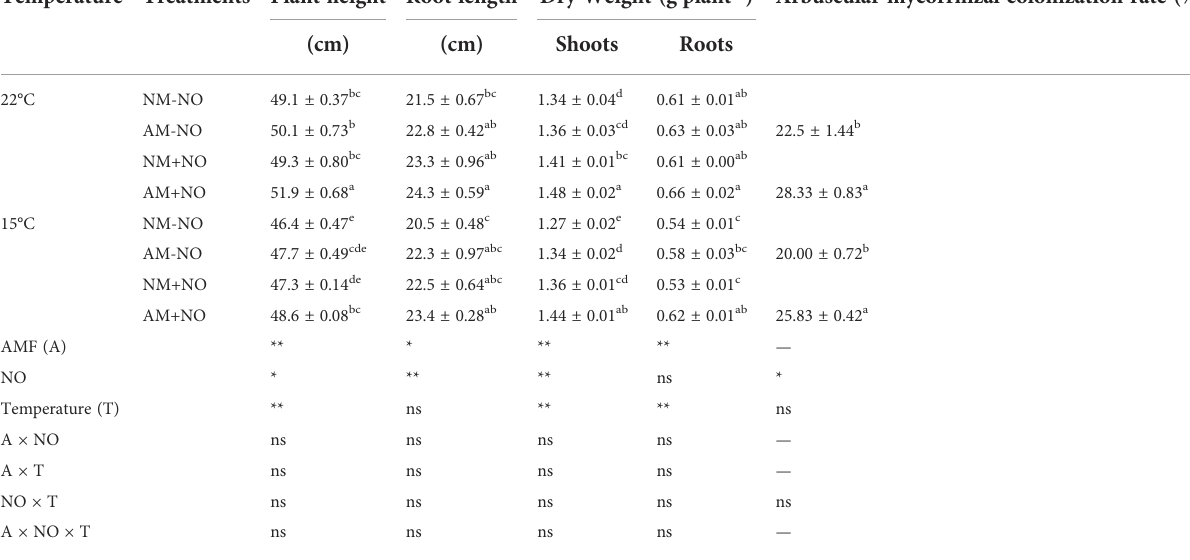
TABLE 2 Effect of NO on rice physiological parameters and arbuscular mycorrhizal colonization rate under different temperature